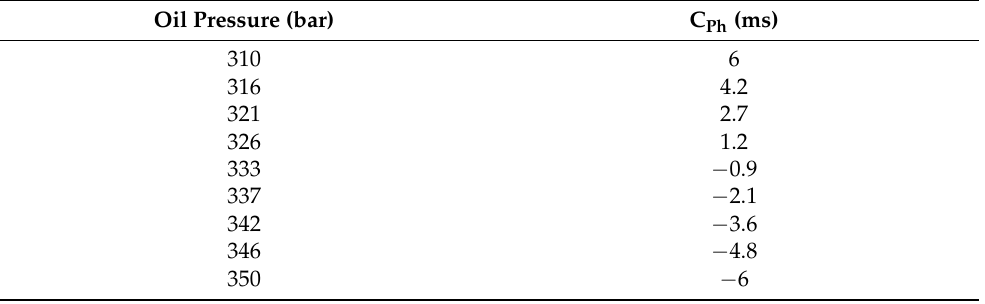
Table 4. Measured values of the dependency of time coefficient on oil pressure.